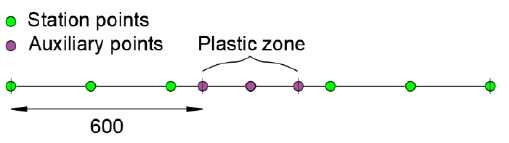
Figure 10. Modeling scheme for the proposed